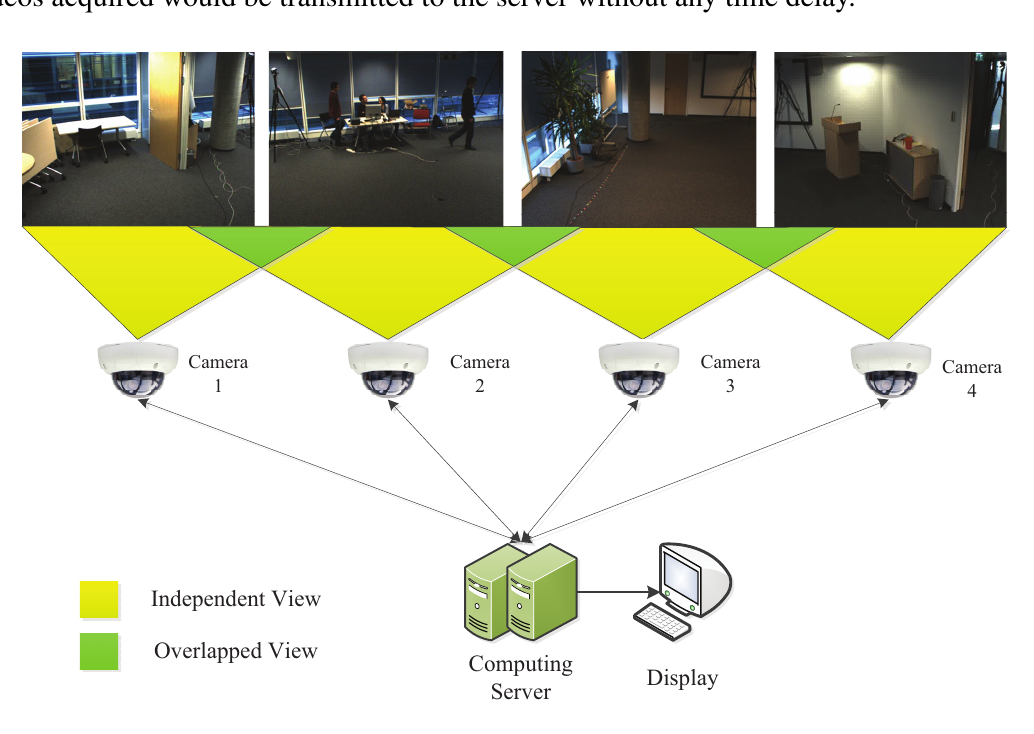
Figure 13. Tracking process with a shared dictionary across all the